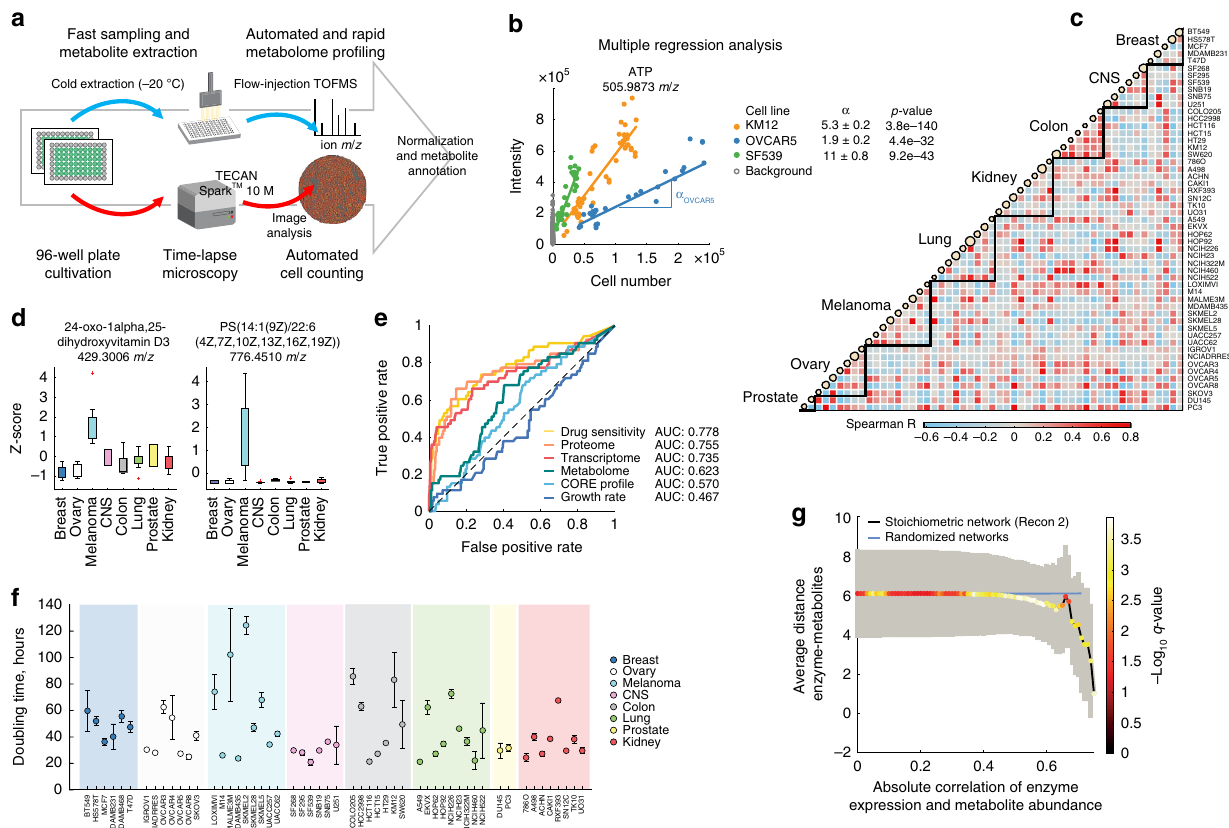
Fig. 1 Comparative metabolome pro fi ling in 54 adherent cancer cell lines. a Schematic overview of the combined work fl ow for high-throughput metabolome pro fi ling in adherent cell lines. Multiple cell lines are cultivated in parallel to collect cell extracts for MS-based metabolome pro fi ling (Supplementary Fig. 1). A new software tool for the segmentation of bright- fi eld microscopy images (Supplementary Note) allows automated cell number quanti fi cation. b Raw MS data for adenosine triphosphate (ATP) in three different cell lines before cell volume correction. Slopes ( α ) and standard errors from the linear fi tting of ion intensity and cell number are reported, together with the p -value signi fi cance. Background intensities were obtained from measurements of cell-free extraction solvent. c Pairwise similarity (Spearman correlation) of metabolome pro fi les among 53 cell lines from the NCI-60 panel. Circle size on the diagonale is proportional to cell line doubling times ( f ). d Examples for metabolites exhibiting a signi fi cantly (ANOVA q -value ≤ 0.05, corrected for multiple tests) tissue-dependent abundance (Supplementary Fig. 4, Supplementary Data 1). Boxplot of Z-score normalized metabolite levels are grouped by the cell line tissue of origin. Box edges correspond to 25th and 75th percentiles, whiskers include extreme data points, and outliers are shown as red plus signs. e Signatures of tissue type in intracellular metabolome pro fi les compared to transcriptome 10 , proteome 11 , drug sensitivity 31 , growth rate and the uptake- and secretion rates of 140 metabolites (CORE pro fi les 13 ). Receiver operating characteristic curve analysis quanti fi es the likelihood of cell lines from the same tissue type to feature similar molecular pro fi les. f Cell line doubling times (mean ± standard deviation), grouped by tissue. Doubling times were determined from continuous monitoring of cell con fl uence in 96-well plates. g Correlations between metabolite levels and gene expression in relation to their distance in the stoichiometric network of human metabolism 21 . The black line represents the average pairwise enzyme- metabolite distance ( y -axis) at different levels of correlation between metabolite abundance and enzyme gene expression ( x -axis). The blue line represents the average enzyme-metabolite distance in 10.000 randomized networks. Dot color re fl ects signi fi cance ( q -value from permutation test) of enzyme- metabolite proximity in the stoichiometric network as compared to the randomized (Fig. 1e), heterogeneity in metabolome pro fi les across cell lines higher throughput, sensitivity, coverage and systematic removal from the same tissue type is consistent with large differences in of biases associated to differences in cell size. doubling times (Fig. 1f, Supplementary Fig. 4, Supplementary Data 1), previous data on exchange rates of nutrients and (Fig. 1c) reveals widespread heterogeneity in the metabolome of metabolic byproducts 13,19 (Fig. 1e) and metabolic differences cell lines even from the same tissue type. We found only 70 metabolites whose intracellular levels exhibited a signi fi cant across mouse tissues 20 (Supplementary Fig. 3). How can such large phenotypic and metabolic diversity emerge dependency (ANOVA, q -value ≤ 0.05) on cell-line tissue (Fig. 1d, under the same environmental condition? We hypothesized that Supplementary Fig. 4, Supplementary Data 1). In few cases, these differential regulation of gene expression could subserve meta- patterns highlighted expected tissue-speci fi c functions, such as for bolic heterogeneity. To test our hypothesis, we correlated mRNA elevated levels of a derivative of vitamin D3 in melanoma cells levels of metabolic enzymes with metabolite abundances, and (Fig. 1d), while other metabolites were ubiquitously present related enzyme-metabolite correlation to their proximity in the among cell lines but in different levels depending on the tissue metabolic network. We used a genome-scale stoichiometric of origin. While previously published transcriptome 10 and proteome 11 pro fi les for 53 of the herein pro fi led cell lines model of human metabolism 21 to derive the distance between revealed a stronger molecular signature of the tissue of origin each enzyme-metabolite pair as the minimum number of